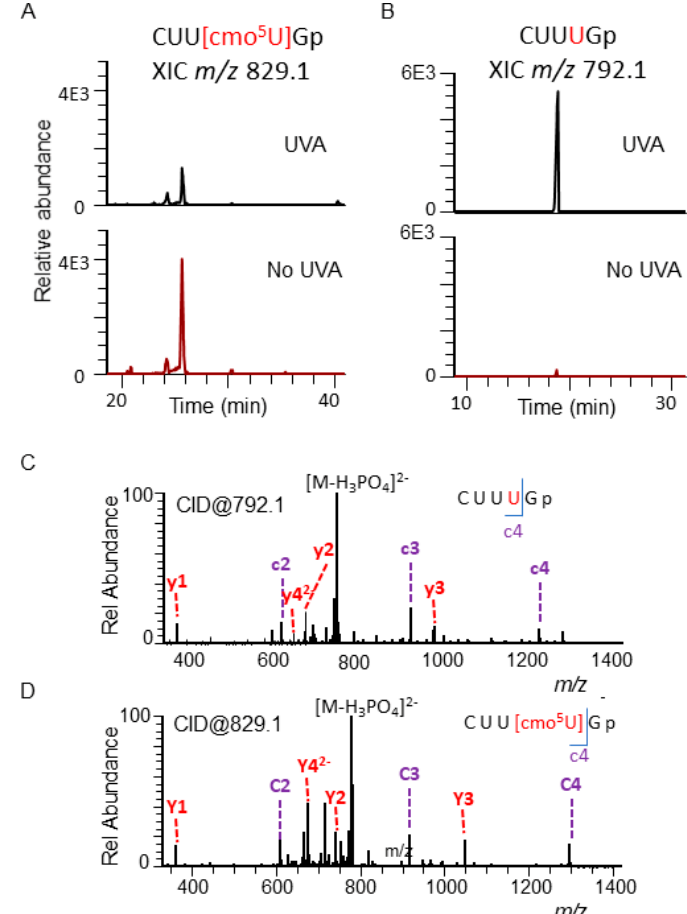
Figure 5. Chemical changes in the anticodon region of tRNA Ala from UVA-exposed and unexposed E. coli cells. ( A ) Comparative levels of modified oligonucleotide, CUU[cmo 5 U]G ( m / z 829.1, position 31–35). ( B ) Comparative levels of CUUUG ( m / z 792.1, position 31–35). ( C ) MS / MS spectrum of m / z 792.1 depicting the sequence informative product ion (color coded c and y fragment) pattern of oligomer as described in Figure 2. ( D ) MS / MS spectrum of m / z 829.1 depicting the sequence informative product ion pattern of oligomer. The position of modification is shown in red font.